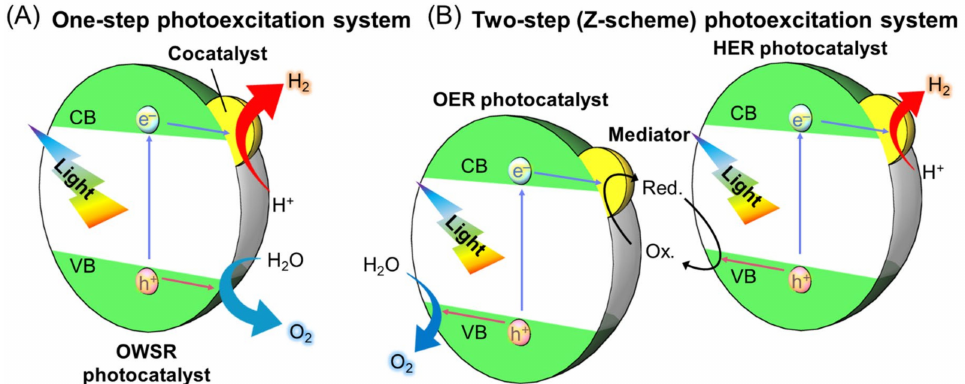
Figure 4. Schematic illustrations of photocatalytic reactions: ( A ) one-step photoexcitation system for overall water-splitting reaction (OWSR); ( B ) two-step (Z-scheme) photoexcitation system for OWSR. Red. and Ox. represent reductants and oxidants,